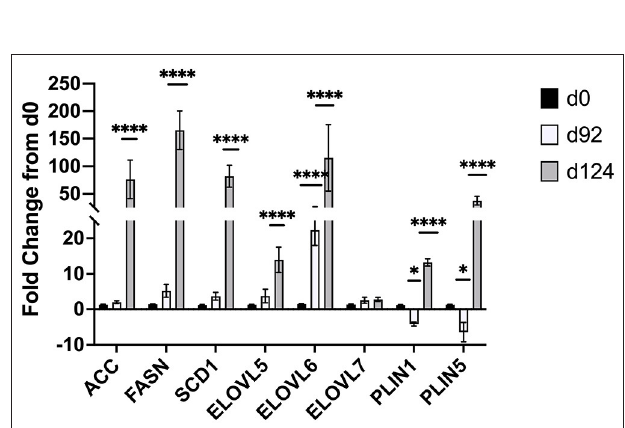
FIGURE 5 | Fold change in mRNA expression of lipogenic (ACC, FASN, SCD1, ELOVL5,6,7) and lipolytic (PLIN1,5) genes at d 92 and d 124 compared to d 0 ( n = 4/time). Differences are noted (* P < 0.05; ** P < 0.01; *** P < 0.001; **** P < 0.0001) in comparison to d